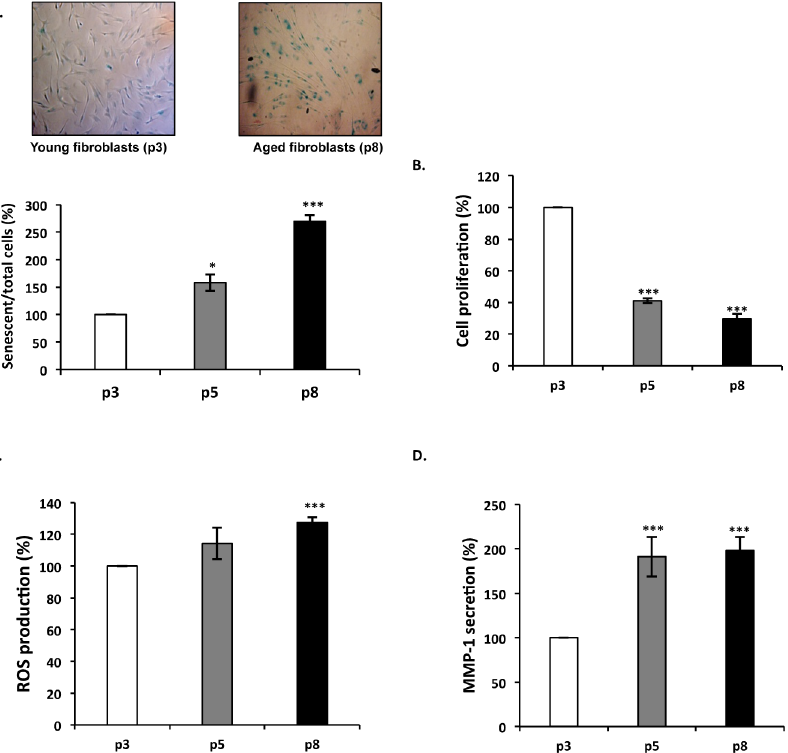
Fig 1. Characterization of the in vitro model of aging. Young, intermediate and aged fibroblasts are represented by passage 3 (white), 5 (gray) and 8 (black bars), respectively. Data shown are representative of three independent experiments. (A) Acid β -galactosidase detection during in vitro aging. Acid β - galactosidase positive senescent cells appear in blue. The histogram reports the senescent/total cells ratio in the three conditions. This ratio was set to 100% for p3. (B) Fibroblasts proliferation is decreased during in vitro aging. Cells were incubated with the Uptiblue reagent and proliferation was evaluated by measuring the absorbance at 560nm. The results are expressed as a percentage of p3 condition value. (C) Evaluation of ROS production during in vitro aging. ROS production was detected by fluorescence using the Image-iT LIVE Green Reactive Oxygen Species Detection Kit. ( λ excitation 495nm / λ emission 529nm). The results are expressed as a percentage of p3 condition value. (D) Evalution of MMP-1 secretion during in vitro aging. MMP-1 secretion was determined by ELISA. The results are expressed as a percentage of p3 condition value. * , p < 0.05, *** , p <